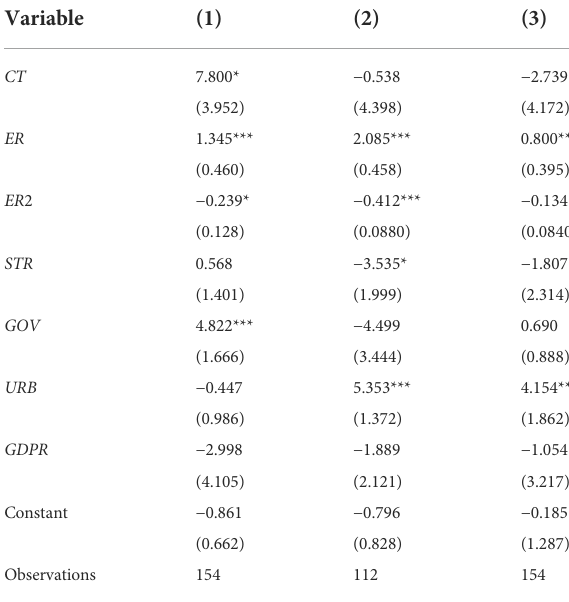
TABLE3Regionaldifferenceresultsoftheimpactofcleantechnology innovation on industrial green total factor